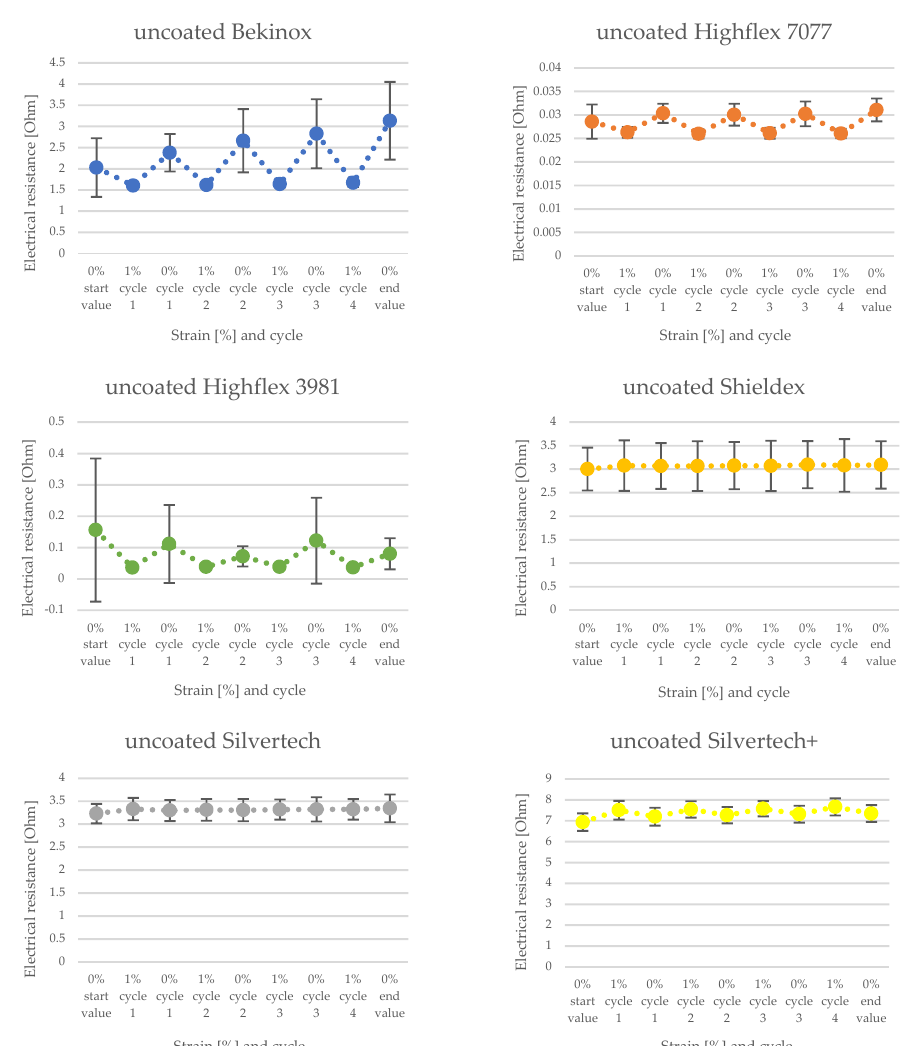
Figure 11. Single display of change of electrical resistance of uncoated substrates with standard deviation. The sensitivity of the substrates can be clarified by the factor of the resistance